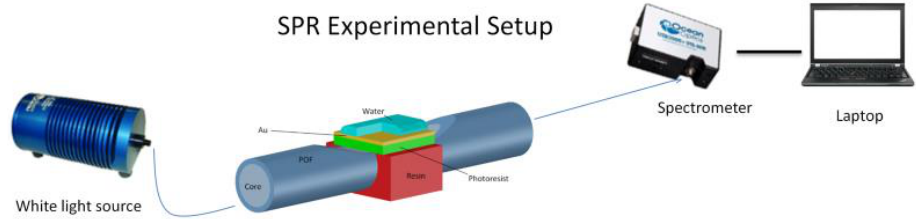
Figure 3. SPR sensor platform based on D-shaped POF [26].